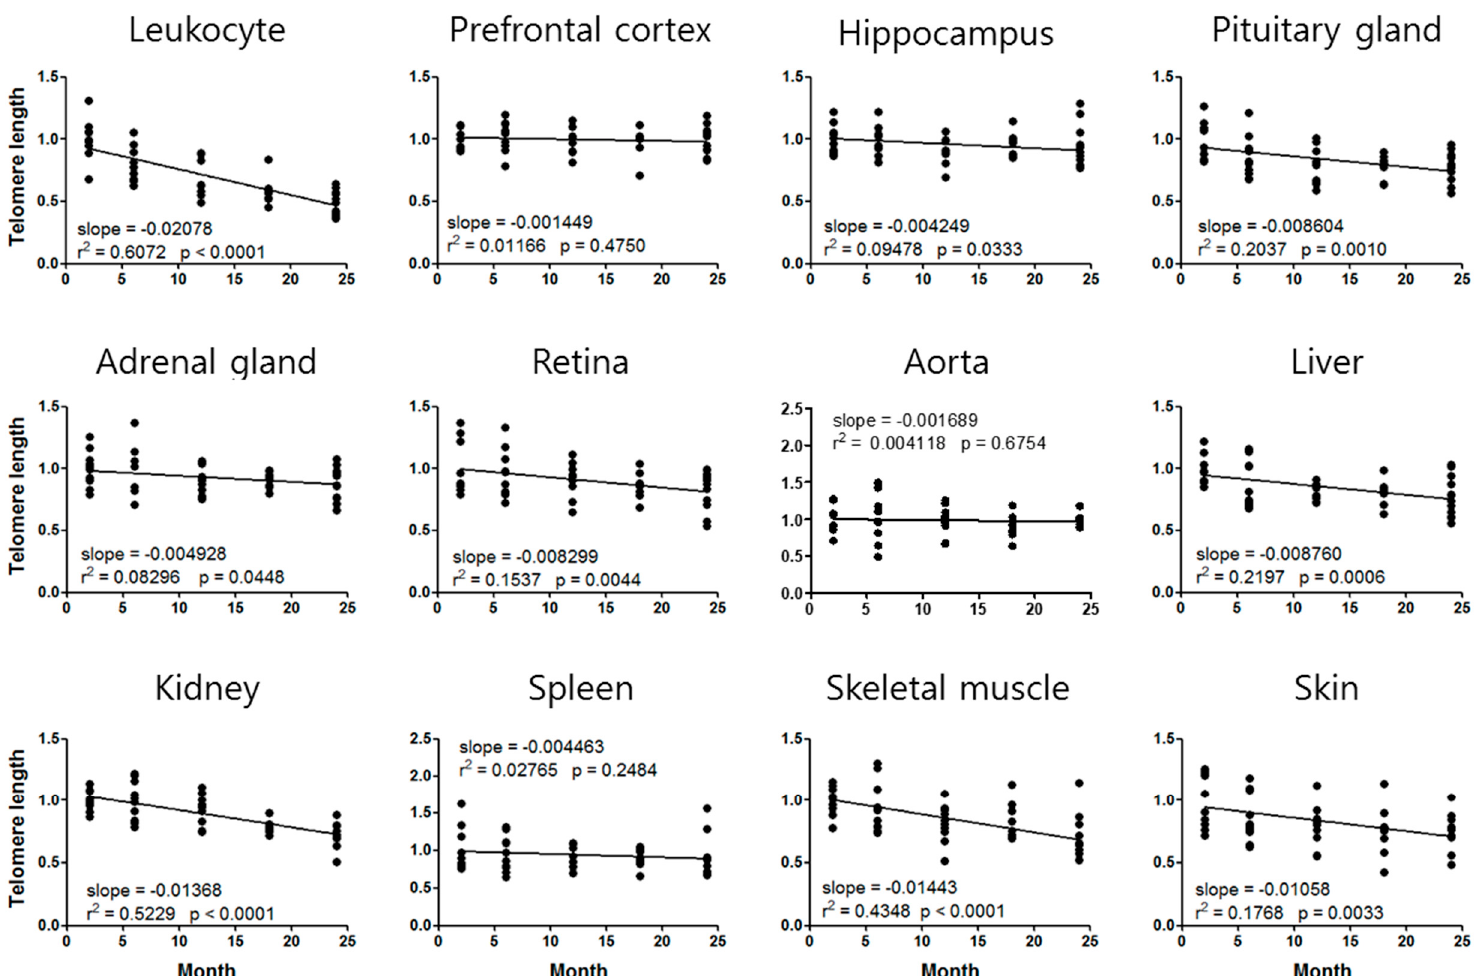
Figure 1. Aging standard curves for telomere length of C57BL/6 male mice. The relative telomere length at 2 months is normalized to 1. The slope of the linear regression line, goodness of fit ( r 2 ), and p -value (whether a slope is significantly non-zero) are provided for each curve.